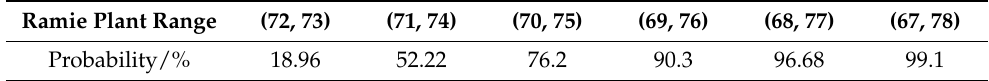
Table 8. Probability of ramie plant range. Ramie Plant Range